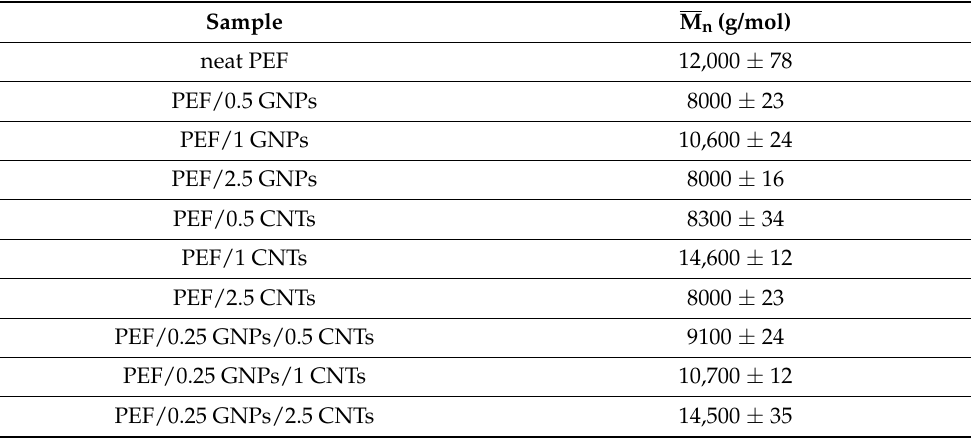
Table 2. Average molecular weight values of neat PEF and PEF/carbon fillers